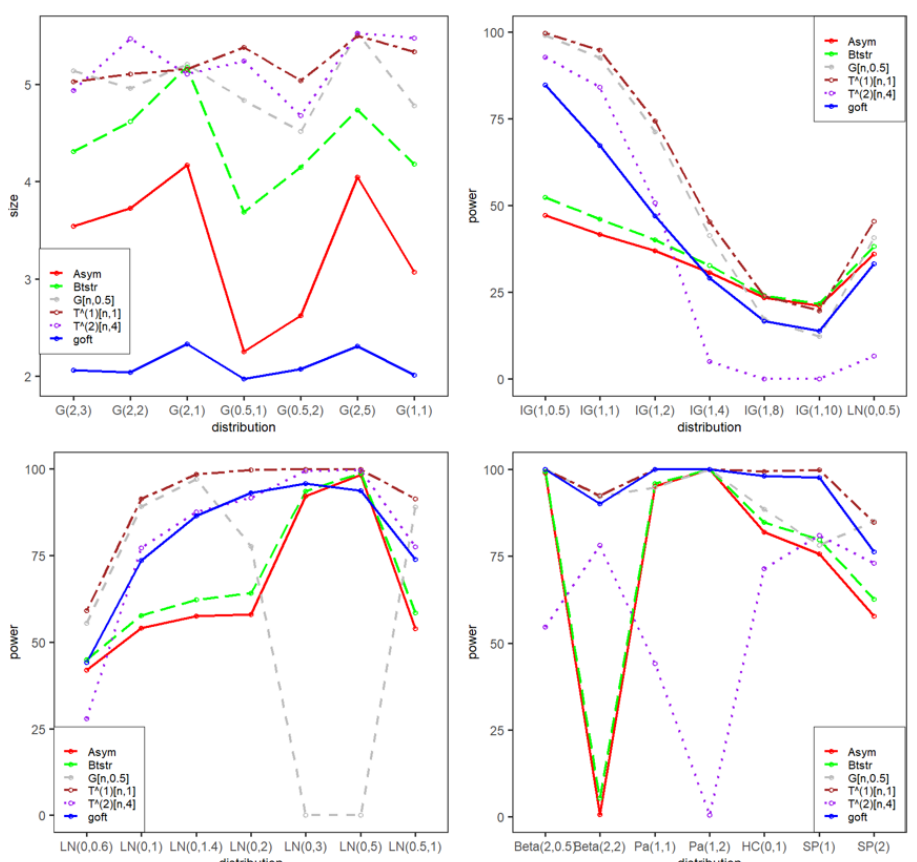
Figure 2. Power curves of the test statistic for 21 alternative distributions, where the null distribution is gamma. The variance M was estimated using the MLE. This figure corresponds to Table 2 in the main text ( n = 100; α =